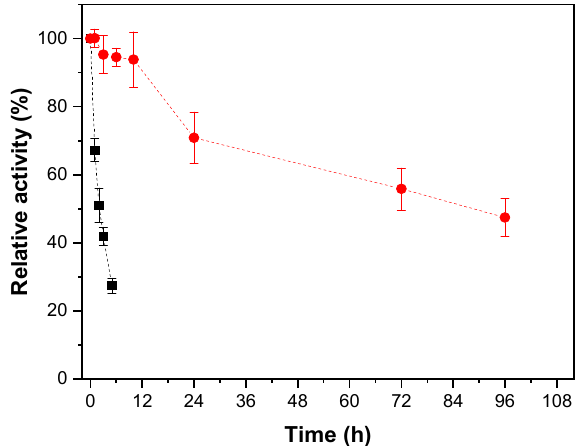
Figure 6. Profile of thermal inactivation at 70 ◦ C of ( (cid:4) ) liquid Eversa and ( • ) Eversa-mCLEA. Assays conditions: Soluble enzyme concentration of 5 mg / mL or 10 mg of Eversa-mCLEA, pH 7.0, 100 mM sodium phosphate bu ff er. The activity of the enzyme initial solution was taken as 100%. Hydrolytic activities were measured with tributyrin as the substrate.